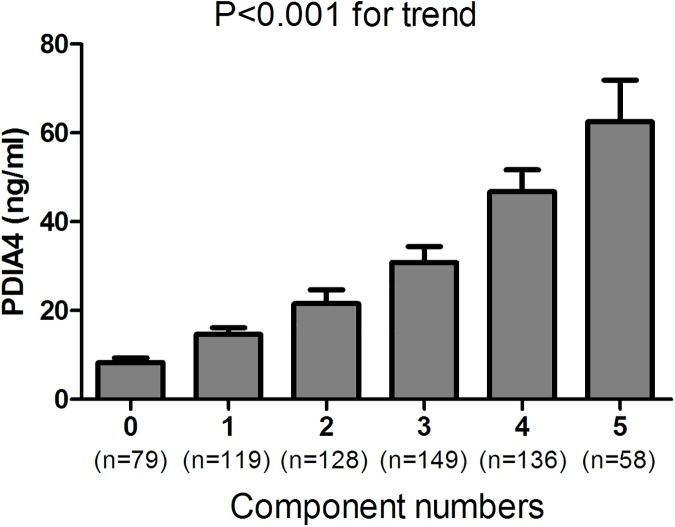
Association of serum PDIA4 levels with the number of MetS components in the study subjects (P<0.001 for trend).Components used to classify individuals with MetS included waist circumference, TG, HDL, blood pressure and fasting blood glucose.